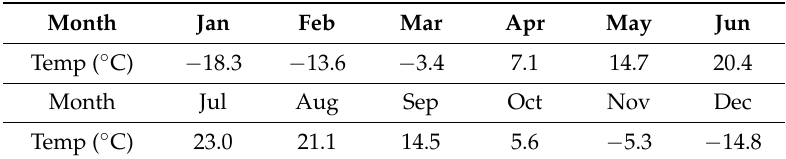
Table 6. The average temperature of the city in Harbin.